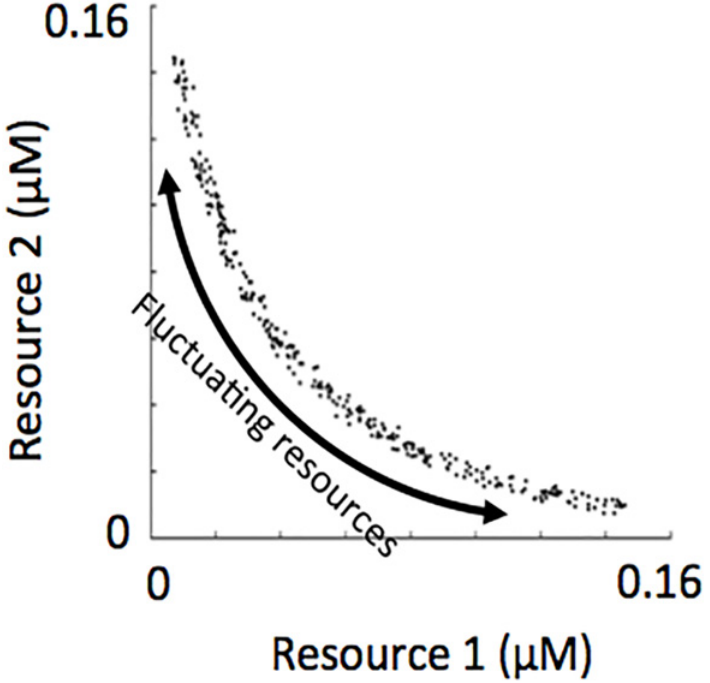
Fig 2. R * s of phytoplankton in the initial species pool and the recurrently fluctuating environmental conditions from which assemblages self-organized.